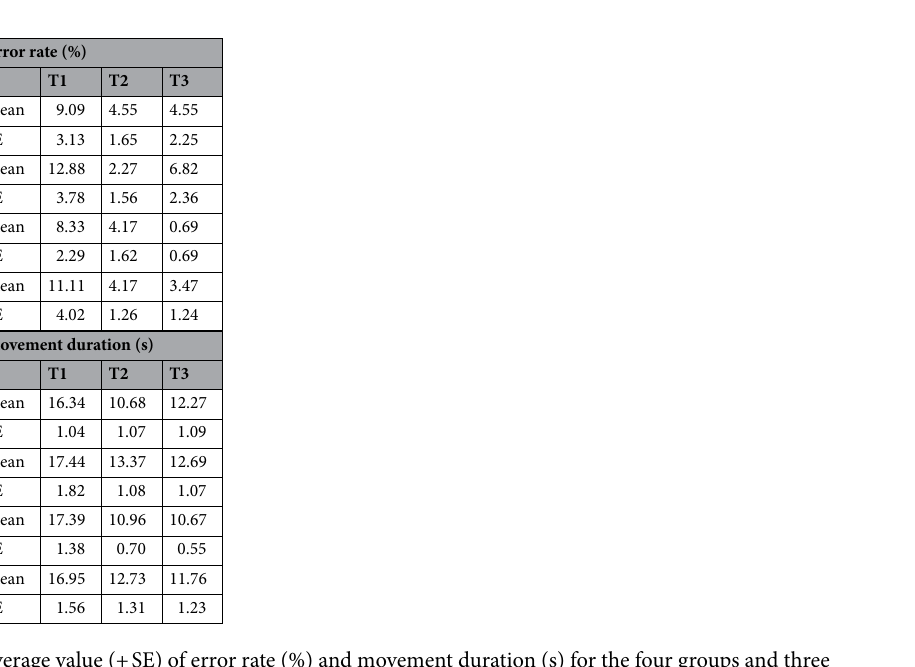
Figure 2. Average values (+ SE) of skill performance for the four groups and the three sessions. The open star indicates significant differences between T1 and T2 and between T1 and T3 for all groups. The black triangle indicates a significant difference between T2 and T3. The white triangle indicates a marginal difference between T2 and T3.